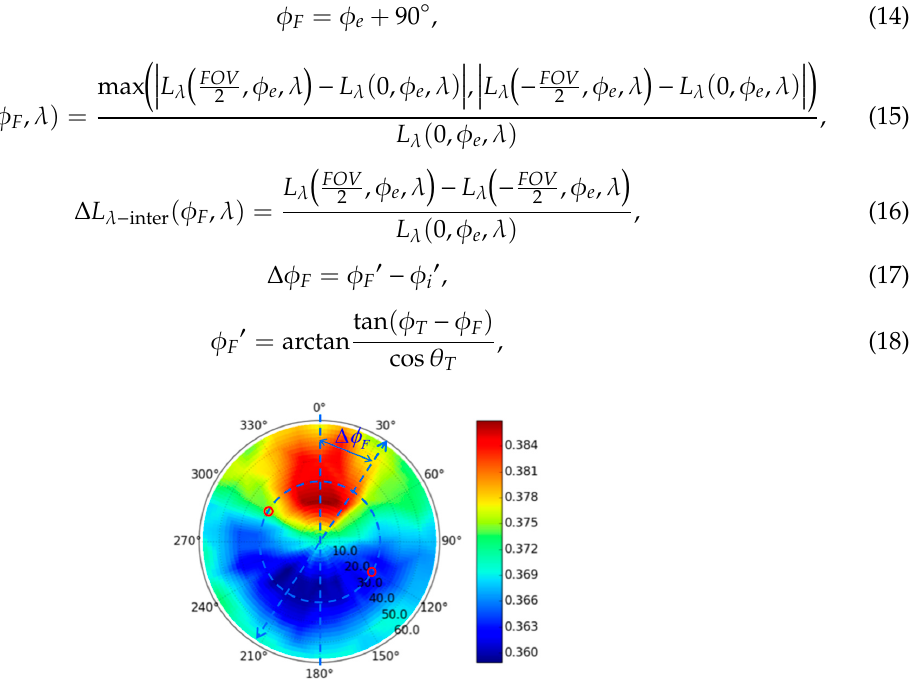
Figure 3. The BRF of sand* [31]. *The azimuth angle changing on circumferential direction align with the blue circle; the zenith angle changing on the radius direction; the blue arrow denotes the flight direction; for specific flight direction, the view directions of two stripes on the same target are the red